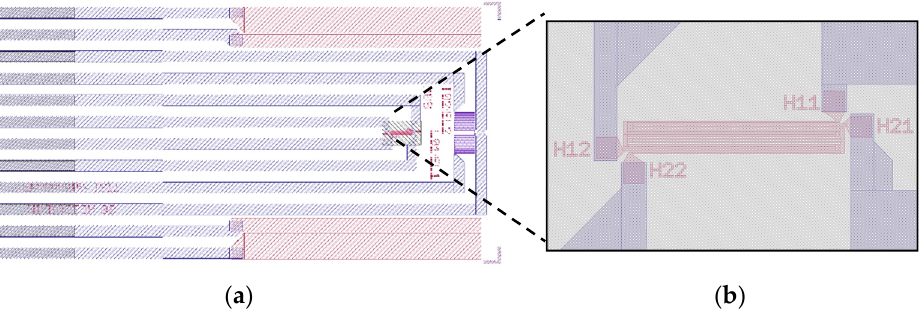
Figure 1. ( a ) Overview of the layout of the sensor. The outer dimensions of the die are 12 mm × 6 mm. ( b ) Detailed view of the heater structure (red) and the membrane area (grey, 890 µm × 550 µm). Only this structure is used in this work.